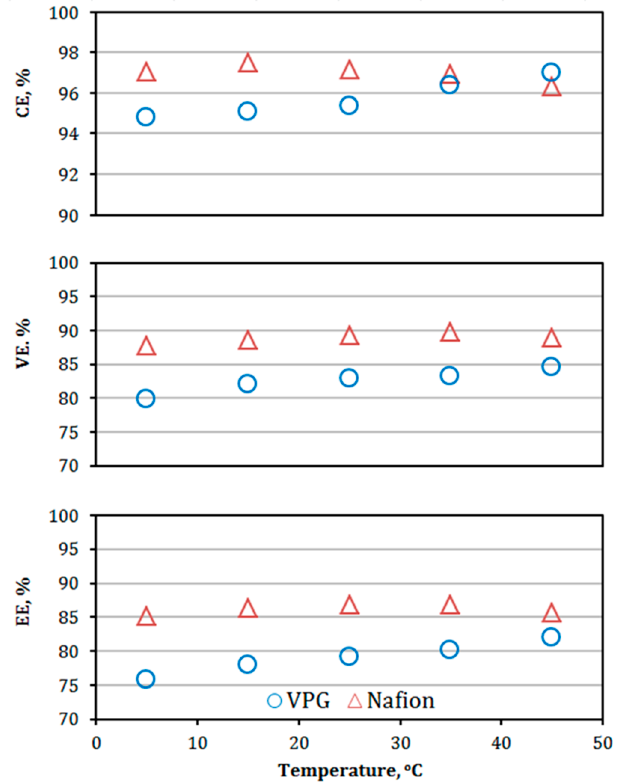
Figure 15. The CE, VE, and EE of the VPG-VRFB and Nafion-VRFB as functions of temperature at a charge and discharge current density of 40 mA/cm 2 .